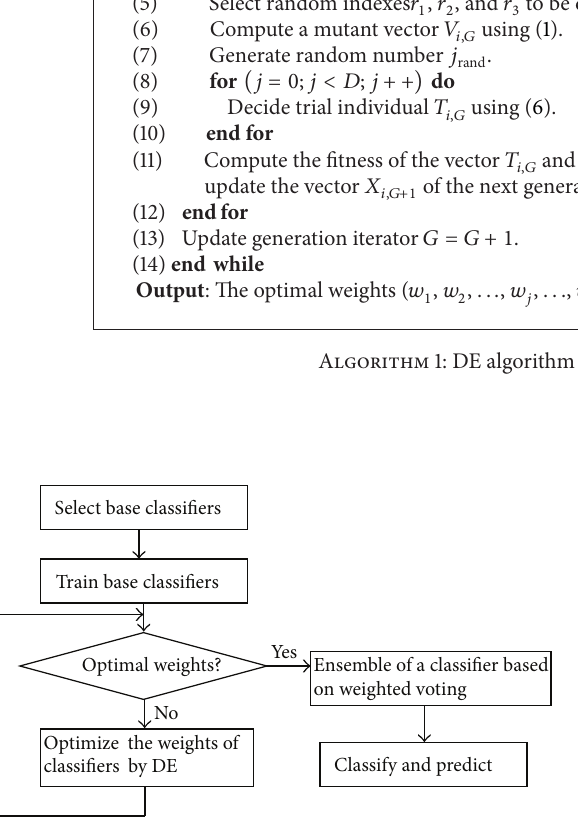
Figure 1: The whole procedure of our proposed approach.